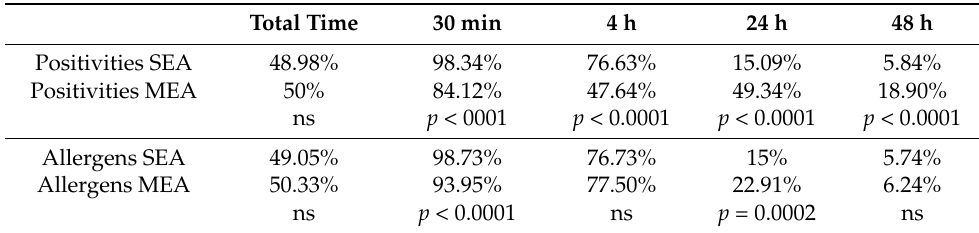
Table 1. Frequencies of positive reactions to any allergens and of the allergens inducing positive reactions at each evaluation time in the severe equine asthma (SEA) and mild-moderate equine asthma (MEA)